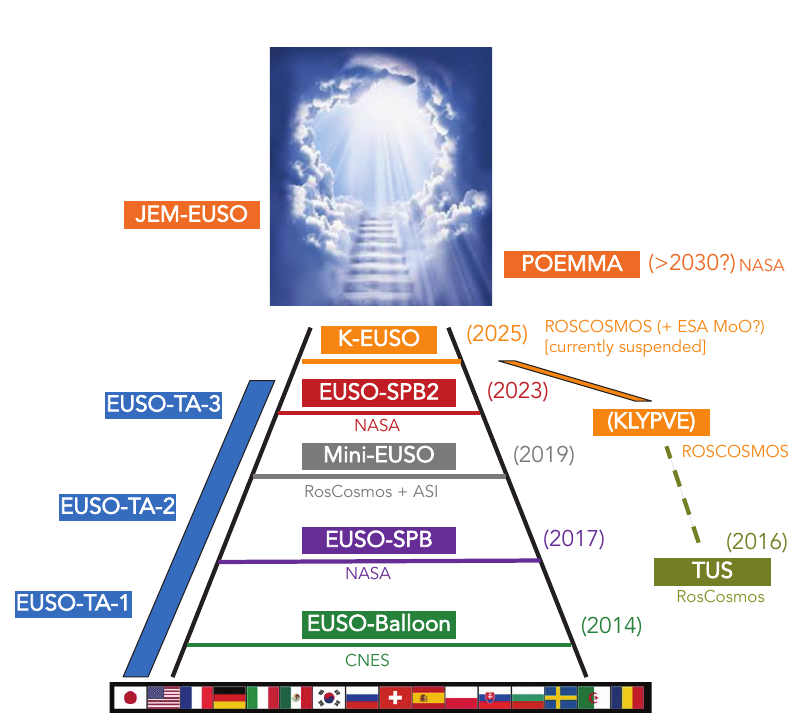
Figure 1. Summary of the JEM-EUSO “stairway to Heaven" development program. (Details in the